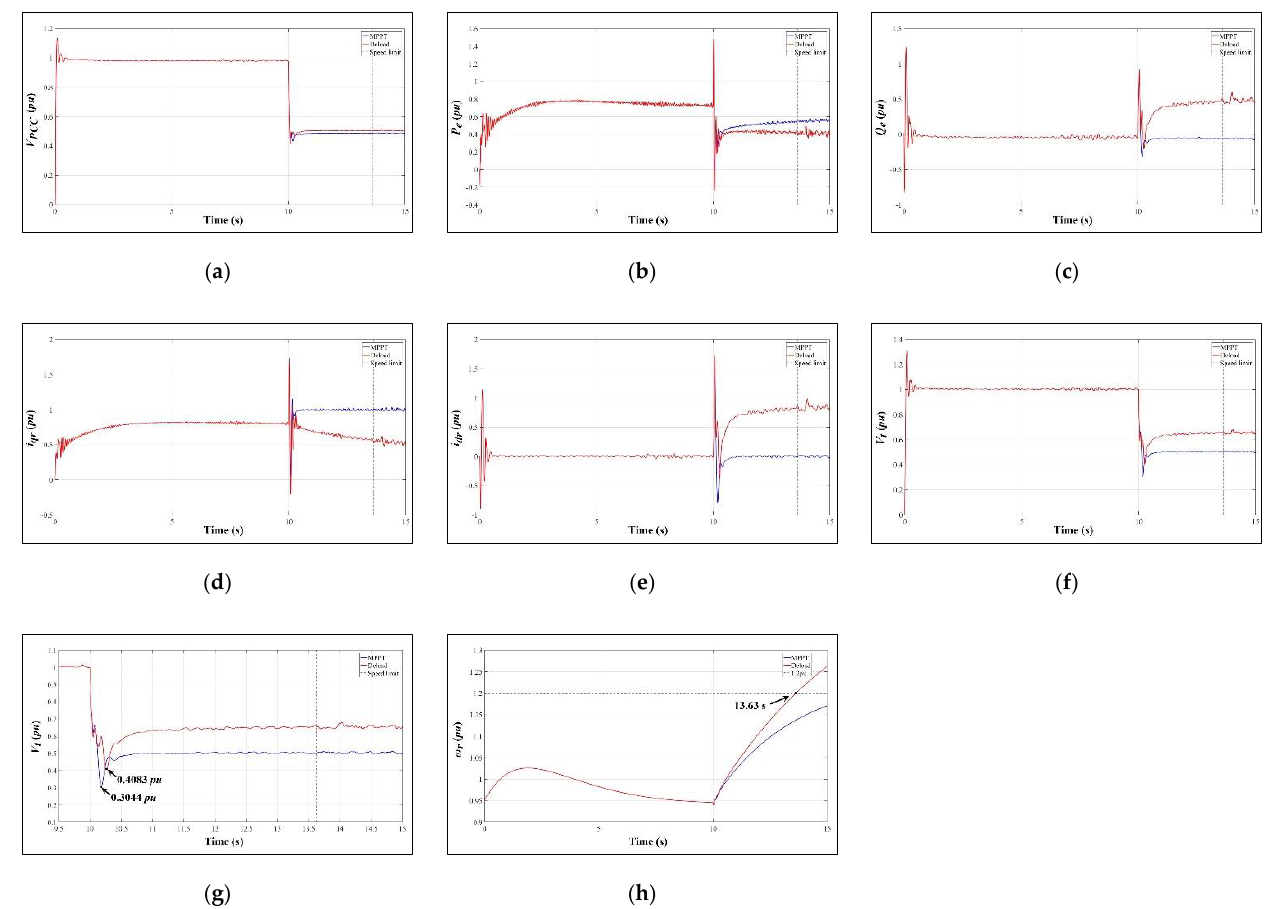
Figure 9. Dynamic response curves for maximum power point tracking (MPPT) operation mode and fixed-gain PI de-loaded controller when the grid is subject to a fault of 0.5 pu . ( a ) Voltage at PCC. ( b ) Wind farm real power. ( c ) Wind farm reactive power. ( d ) q -axis rotor current. ( e ) d -axis rotor current. ( f ) Wind farm terminal voltage. ( g ) Enlarged version of the terminal voltage. ( h ) Generator speed.